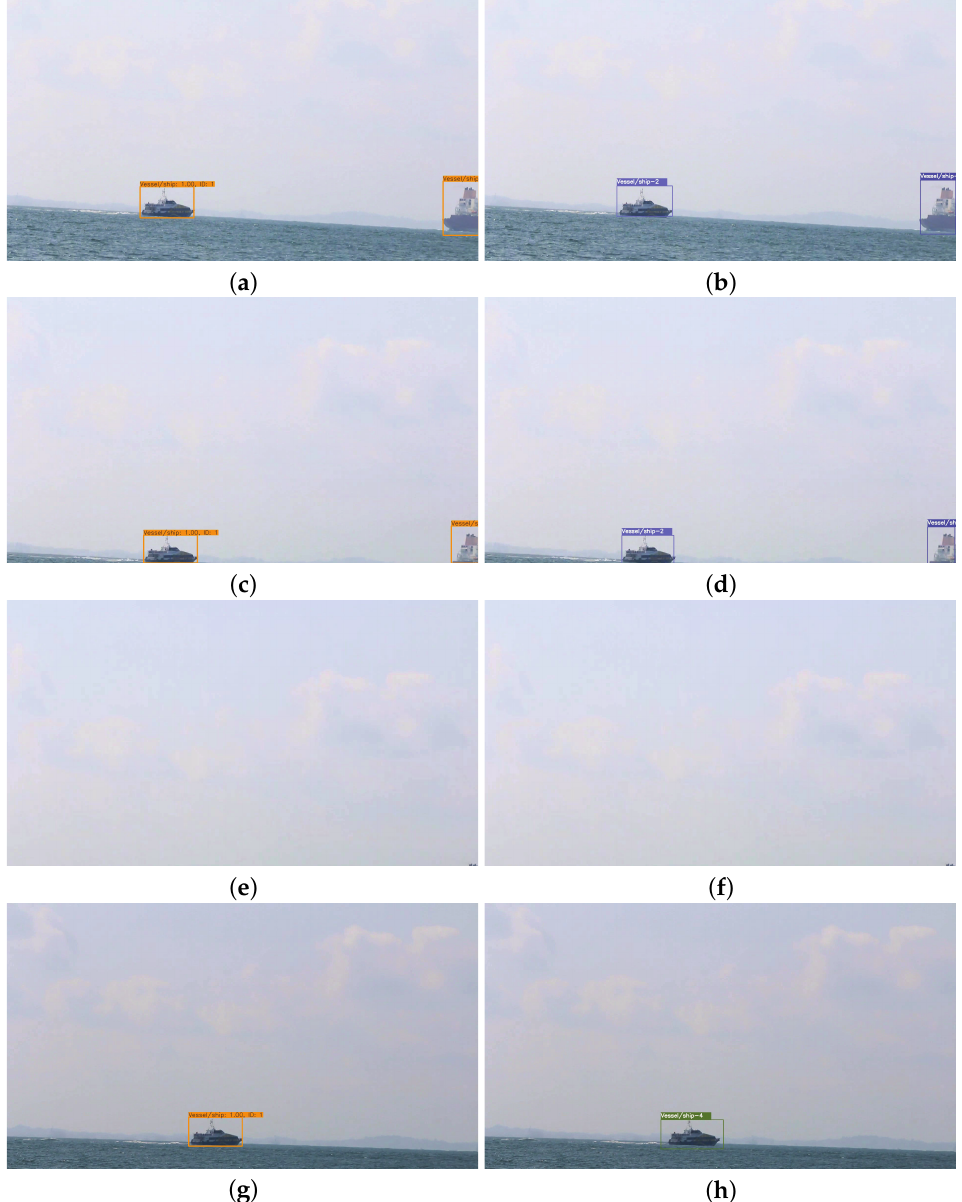
Figure 12. The test case for object tracking. ( a ) Proposed tracking scheme in 70th frame. ( b ) DeepSORT in 70th frame. ( c ) Proposed tracking scheme in 75th frame. ( d ) DeepSORT in 75th frame. ( e ) Proposed tracking scheme in 80th frame. ( f ) DeepSORT in 80th frame. ( g ) Proposed tracking scheme in 95th frame. ( h ) DeepSORT in 95th